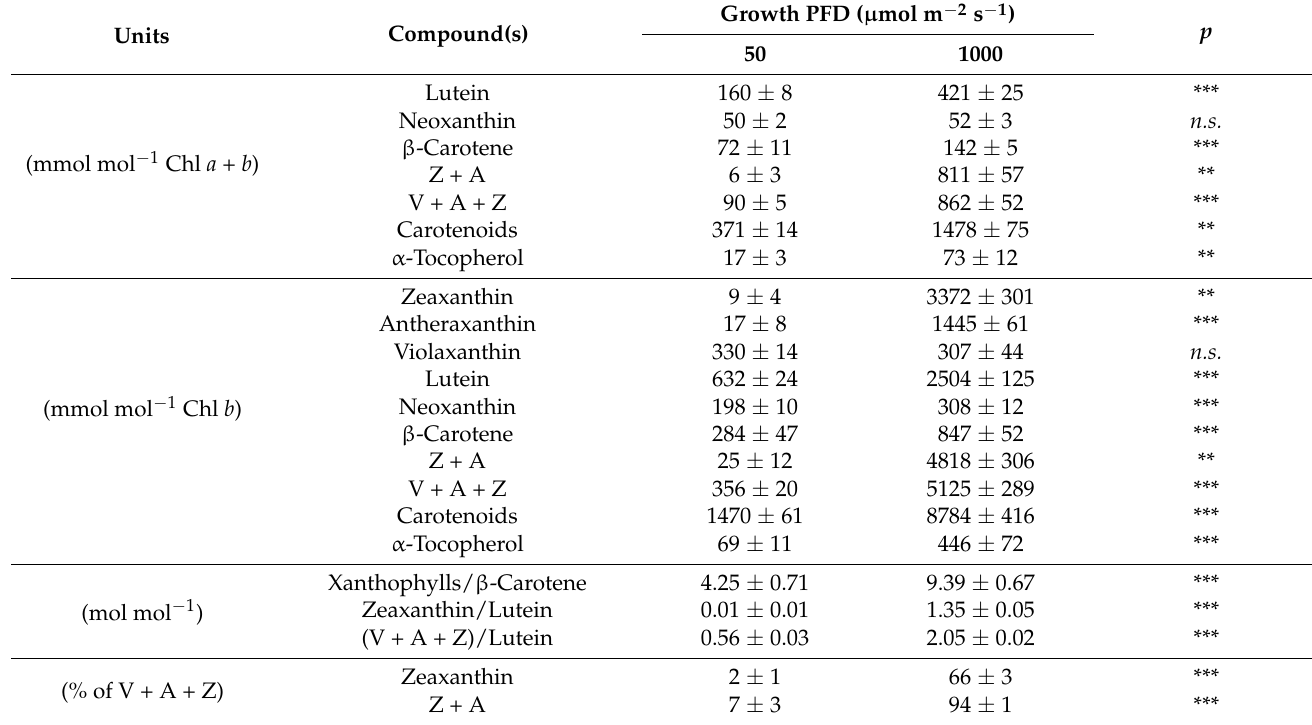
Table 2. Levels of carotenoids and α -tocopherol relative to chlorophylls (Chl) or other carotenoids in fronds of Lemna gibba grown under PFDs of 50 or 1000 µ mol m − 2 s − 1